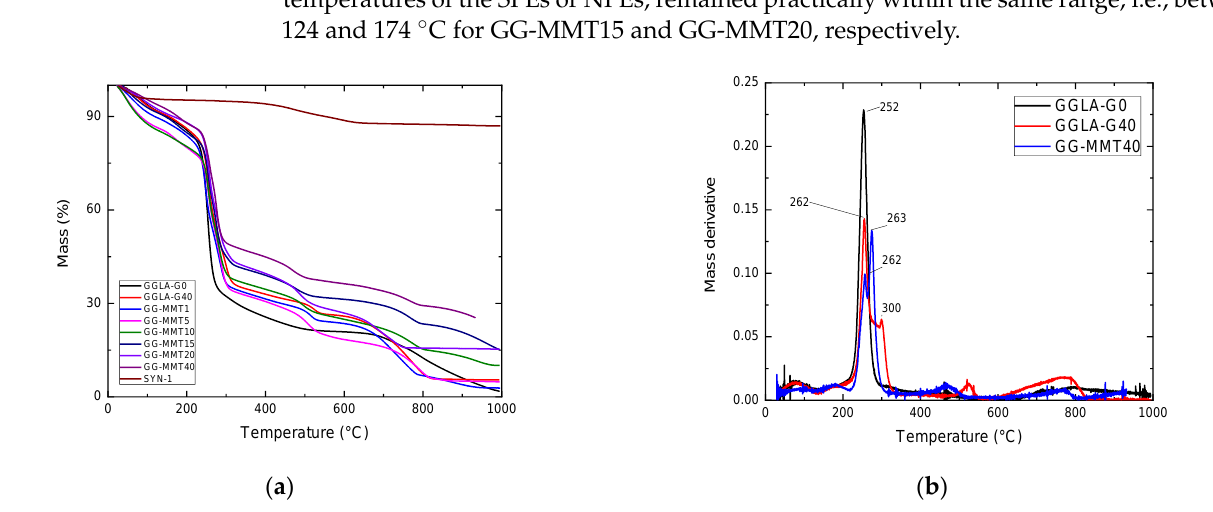
Figure 4. TGA of clay, GGLA-G0, GGLA-G40 and GGLA-MMT NPEs ( a ) and mass derivative of GGLA-G0, GGLA-G40 and GG-MMT40 ( b ). The DSC measurements of the samples GGLA-G40, GG-MMT10 and GG-MMT40 did not show any thermal event in the temperature range from −6 0 to 80 °C (Figure S1). The XRD diffractogram of Na + SYN-1 clay shows that it has a basal spacing of approx- imately 11.2 Å (2θ ≈ 7.96°), which is in agree ment with the literature (Figure 5). GG-MMT1